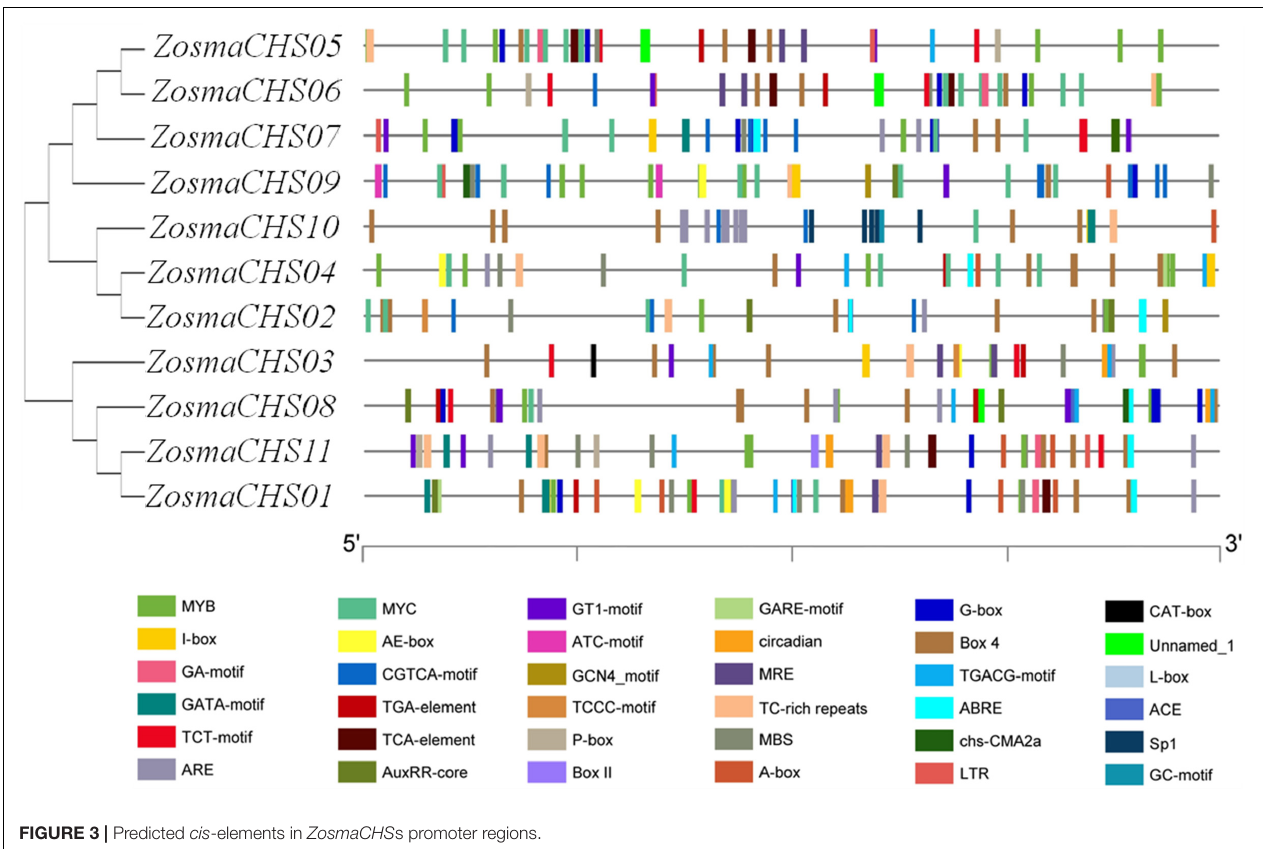
FIGURE 3 | Predicted cis -elements in ZosmaCHS s promoter regions.